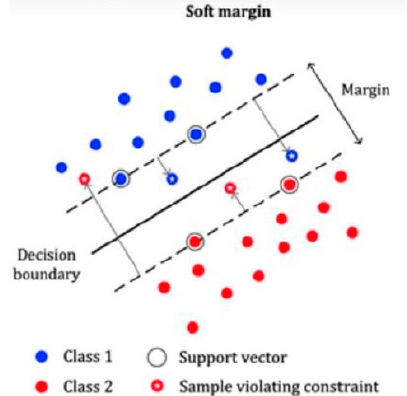
Figure 3. Represents the case of soft margin where data are not easily separable.